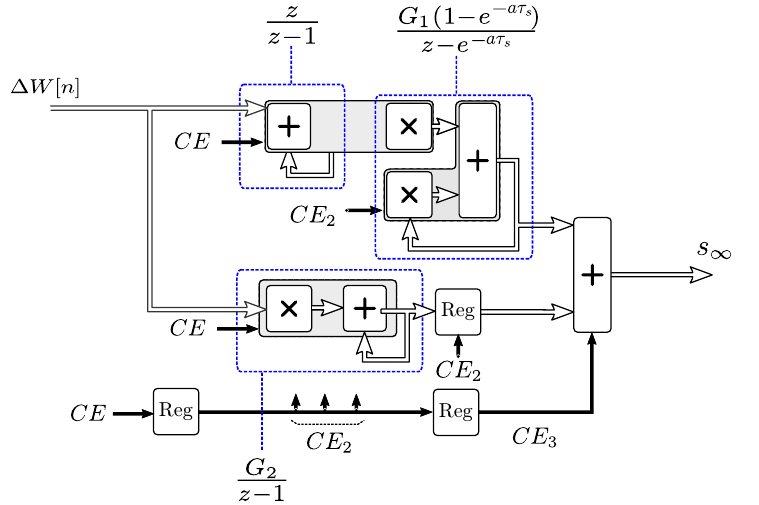
Figure 9. IIR filter implementation for the last